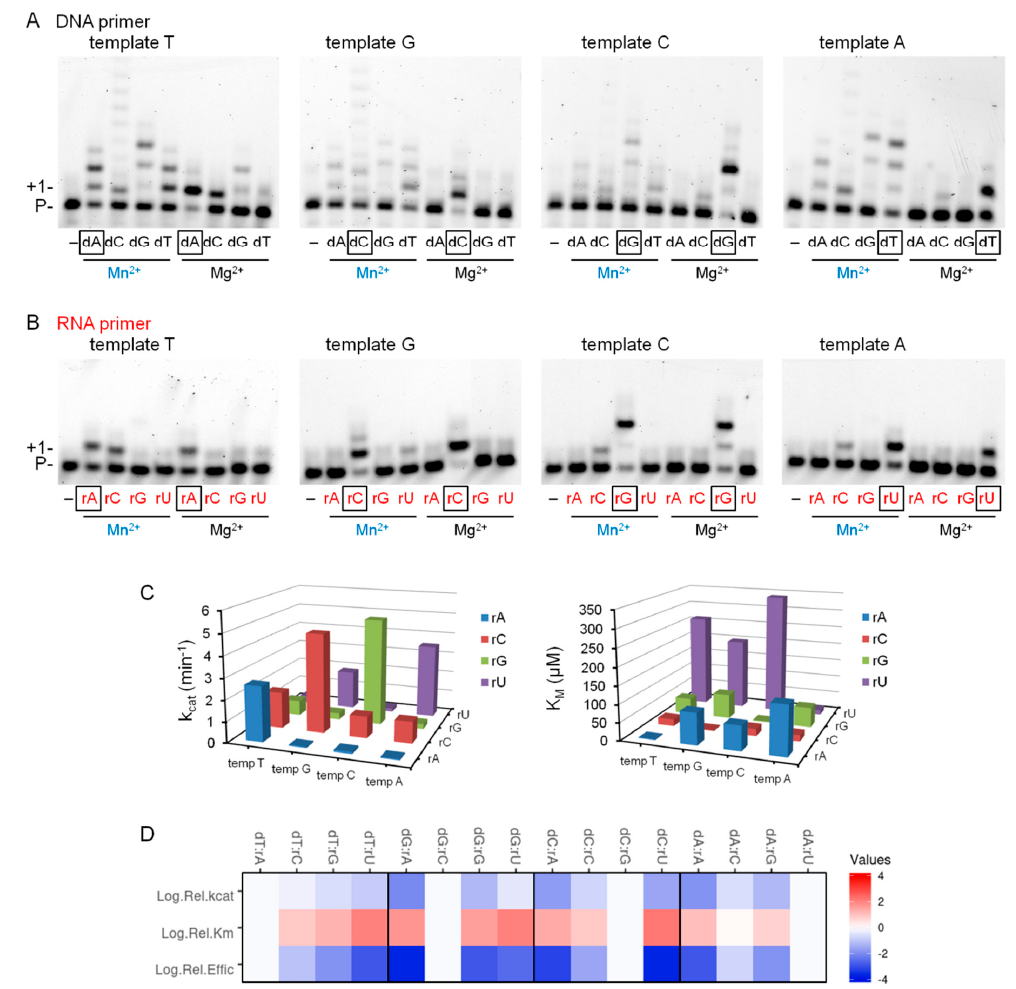
Figure 3. Fidelity of Pol η during DNA and RNA synthesis in the presence of magnesium or manganese. ( A , B ) Reactions contained 5-mM Mn 2+ or Mg 2+ as indicated, 6-nM Pol η , 20-nM ( A ) DNA/DNA (S1–4) or ( B ) RNA/DNA (S5–8) primer/template, and ( A ) 0.1-mM individual dNTPs or ( B ) 4 mM individual rNTP, as indicated. Reaction times were 1 min except for the 15-min reactions with Mg 2+ in ( B ). The templating base in the incoming position is denoted. RNA primer and rNTPs are highlighted in red, and manganese is in blue. The nucleotides representing correct insertions are boxed. ( C ) Measured k cat (left) and K M (right) values of various ribunucleotide incorporations opposite the indicated templating bases. ( D ) Heat map showing relative catalytic constants of incorporation of incorrect versus correct rNTPs. Log.Rel.kcat = Log10(k cat incorrect /k cat correct ), Log.Rel.Km = Log10(K M incorrect /K M correct ) and Log.Rel.Effic = Log10 [(k cat /K M ) incorrect /(k cat /K M ) correct ]. Heat map was generated using http://www.heatmapper.ca [40].